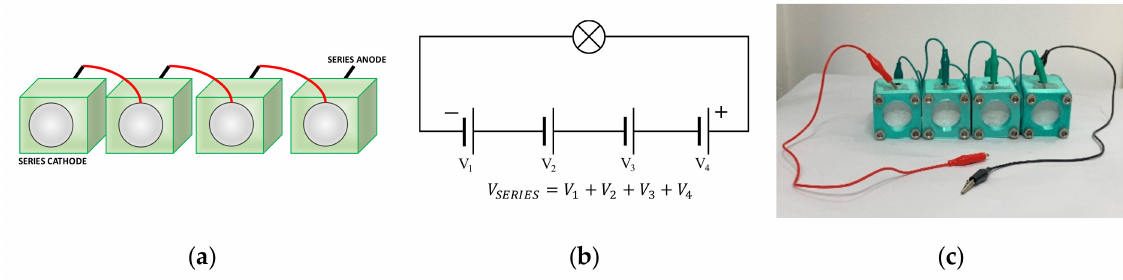
Figure 4. Series-based configuration: ( a ) scheme, ( b ) electrical connection mode and ( c ) stacked MFCs tested in lab.